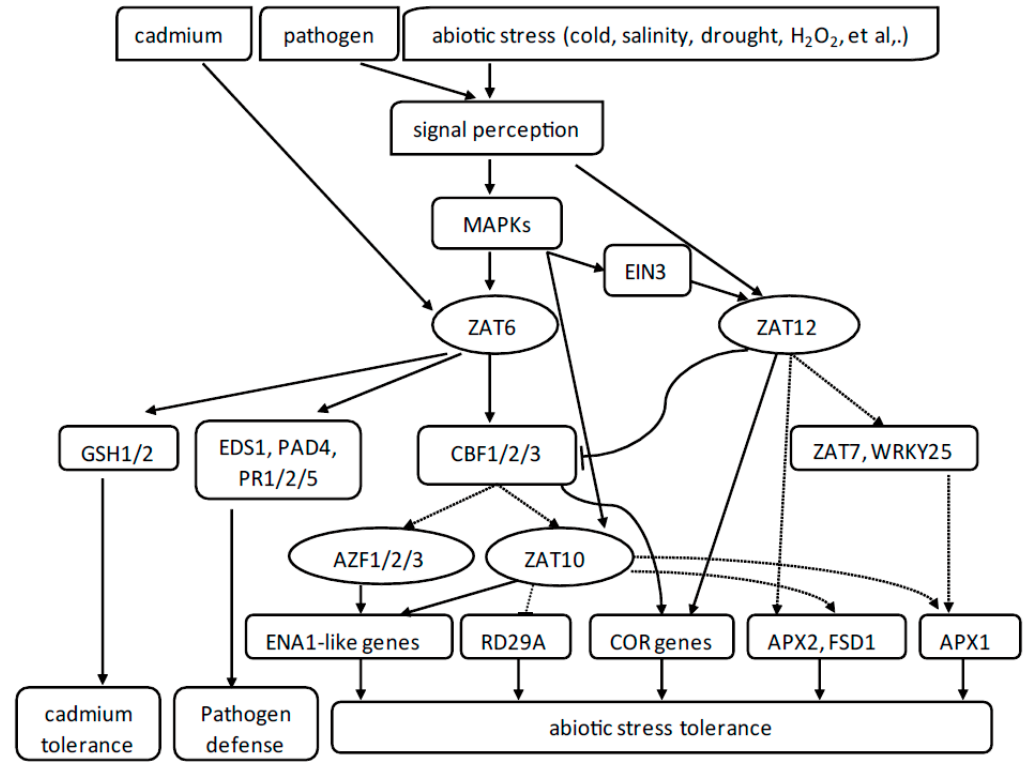
Figure 3. A hypothetical model of links between different members of C1-2i subclass of C2H2-type zinc-finger proteins (ZFPs) from Arabidopsis . AZF1 / 2 / 3 ( Arabidopsis zinc-finger protein 1 / 2 / 3), ZAT6 (zinc finger of Arabidopsis thaliana 6), ZAT7, ZAT10, and ZAT12 are C2H2 zinc-finger transcription factors in the C1-2i subclass. Solid arrows represent positive regulation, T-bars represent negative regulation, and dotted arrows represent indirect regulation. Abbreviations: MAPKs, mitogen-activated protein kinases; CBF, C-repeat binding factor; EIN3, ethylene-induced 3; GSH1 / 2, glutathione 1 / 2; EDS1, enhanced disease susceptibility 1; PAD4, phytoalexin deficient 4; PR1 / 2 / 5, pathogenesis-related gene 1 / 2 / 5; ENA1-like genes, encoding a Na + -ATPase-like genes; RD29A, responsive to dehydration 29A; COR genes, cold-responsive genes; APX1 / 2, ascorbate peroxidase 1 / 2; and FSD1, Fe-superoxide dismutase 1.